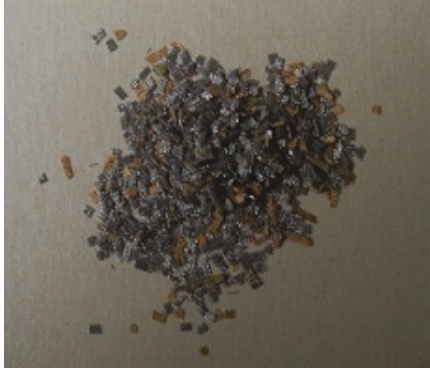
Figure 5: High-friction fl aky